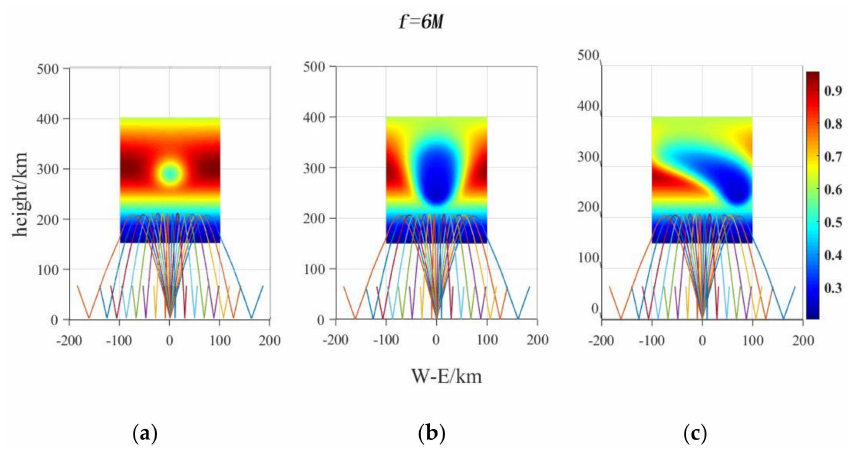
Figure 3. 3D ray-tracing simulation of 6 MHz short wave propagation path after 100 s of H 2 released by rocket under different flight paths (electron density unit: 10 6 cm − 3 ): ( a ) 300 km fixed − point release, ( b ) 250 − 350 km vertical path, ( c ) 250 − 350 km parabolic